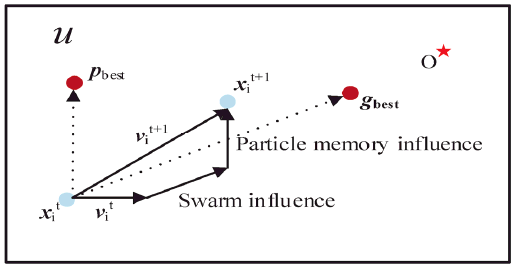
Figure 7. PSO population movement update.